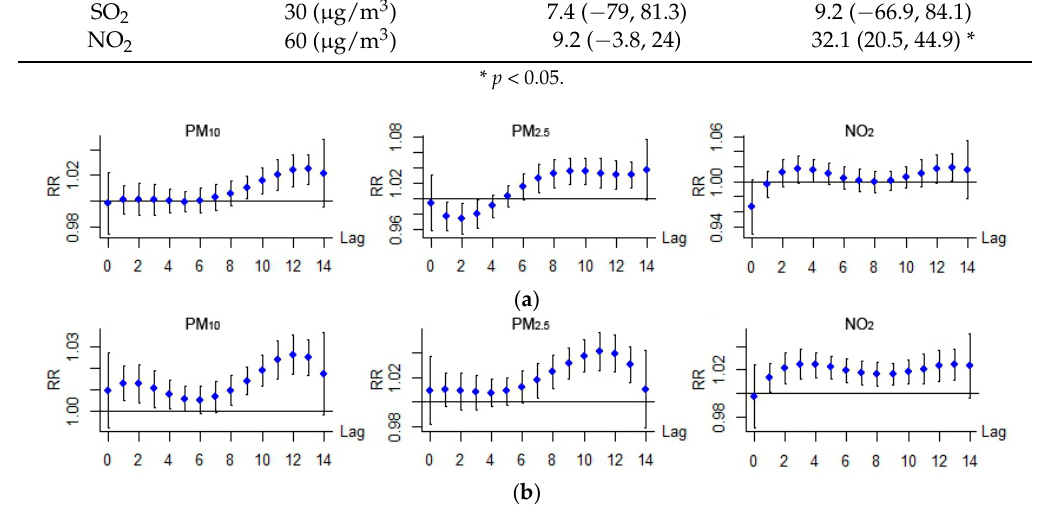
Figure 3. Lag–response relationship between air pollutant and RR for hospital admission of acute respiratory infection. ( a ) Acute upper respiratory infection; ( b ) Acute lower respiratory infection.